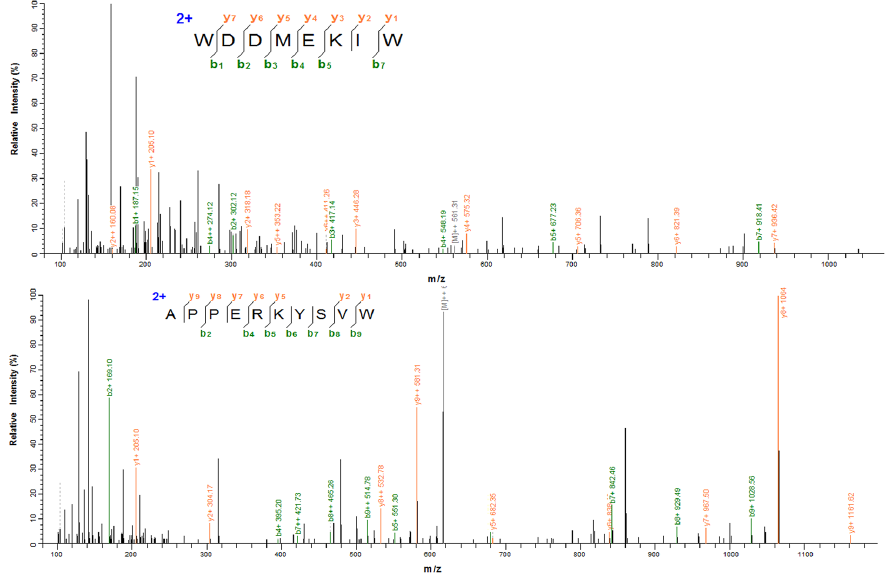
Table 3. Prediction of physicochemical properties of active peptides.